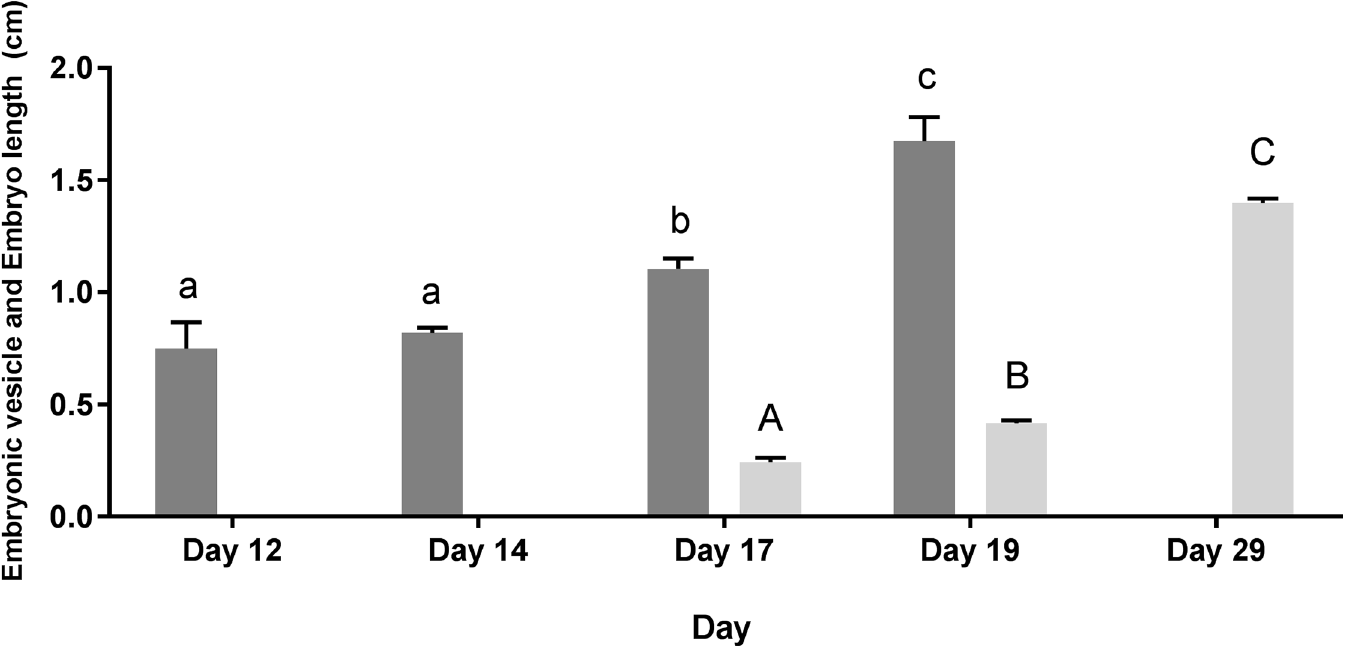
Fig 5. Average length of embryonic vesiclesmeasuredon day 12, 14, 17 and 19 (dark grey bars) and embryos measuredon day 17, 19 and 28 (light grey bars). Valuesare averagedover ewe ± SEM. Columns without common superscripts differ significantly; lowercaseindicatessignificancein relationto embryonicvesicle size, while capitalisedletters indicatesignificancein relationto embryo size (P < 0.05).